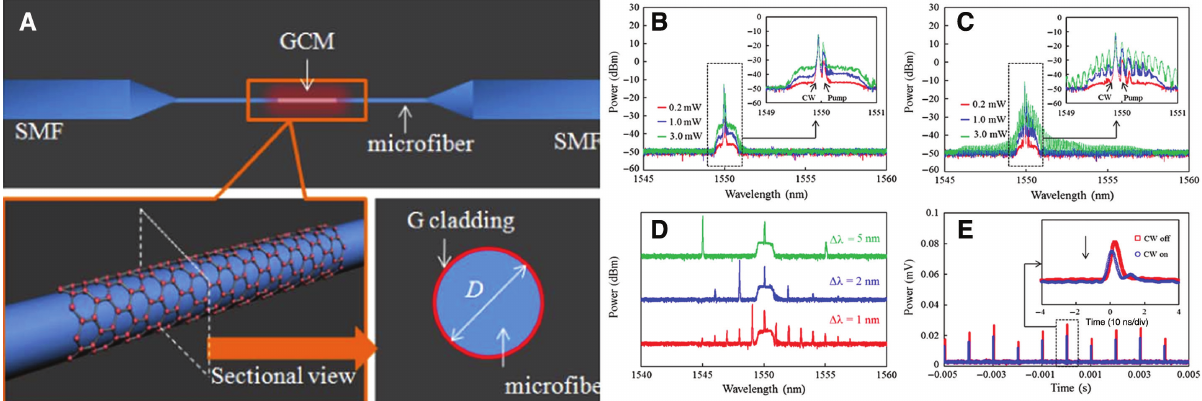
Figure 21: Cascaded FWM based on a graphene/microfiber hybrid waveguide. (A) Schematic diagram of the GCM, in which graphene is wrapped around the microfiber with diameter D . (B) For the microfiber without graphene, no FWM was observed (1545–1560 nm). Inset: zoom-in figure with the window of 1549–1551 nm. (C) Spectra of the GCM under the pump powers of 0.2 mW (red), 1.0 mW (blue), and 3.0 mW (green). Inset: zoom-in figure with the window of 1549–1551 nm. (D) Spectra of cascaded FWMs for the detuning of 1 nm (red), 2 nm (blue), and 5 nm (green), respectively. (E) Time profile of the transmitting light of the GCM, before CW launched (red boxes) and after CW launched (blue circles). Reproduced with permission [284]. Copyright 2015, The Optical